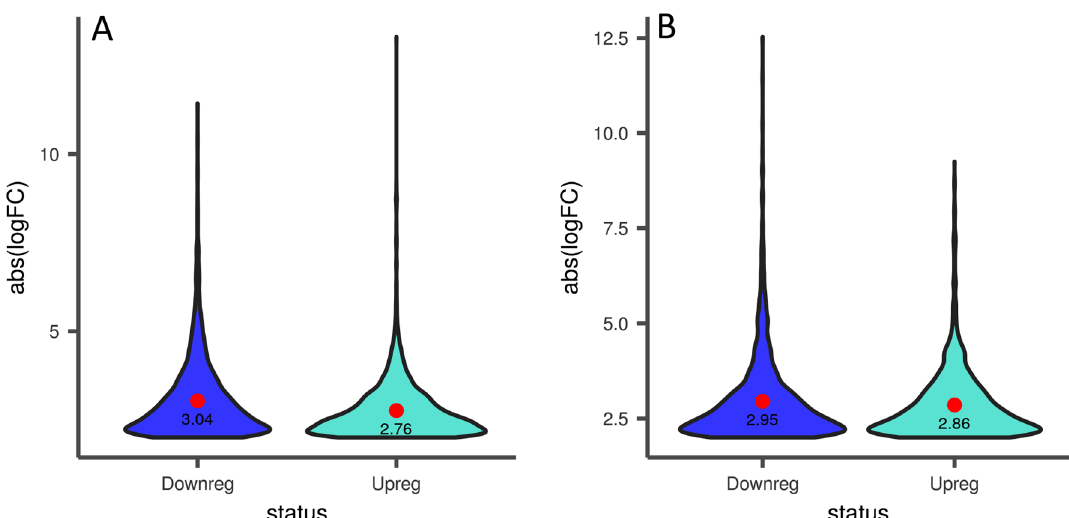
Figure 8. Violin plot representing the log 2 FoldChanges of differentially expressed up-regulated and down- regulated ( A ) isoforms and ( B ) unigenes. The value within the violin indicates average log 2